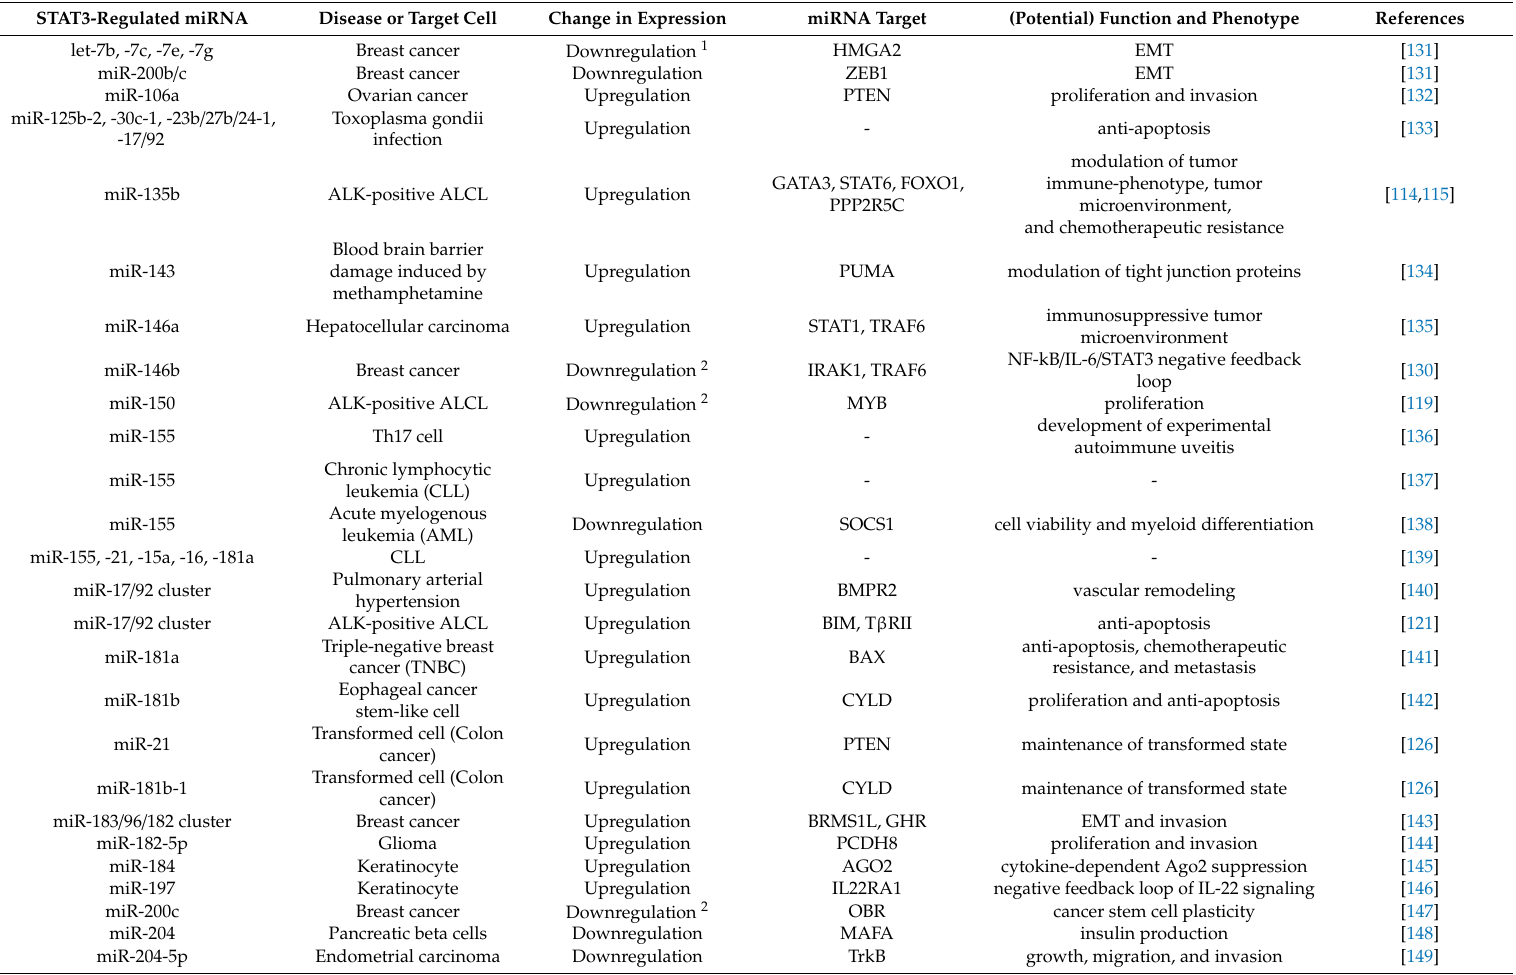
Table 1. Summary of miRNAs regulated by